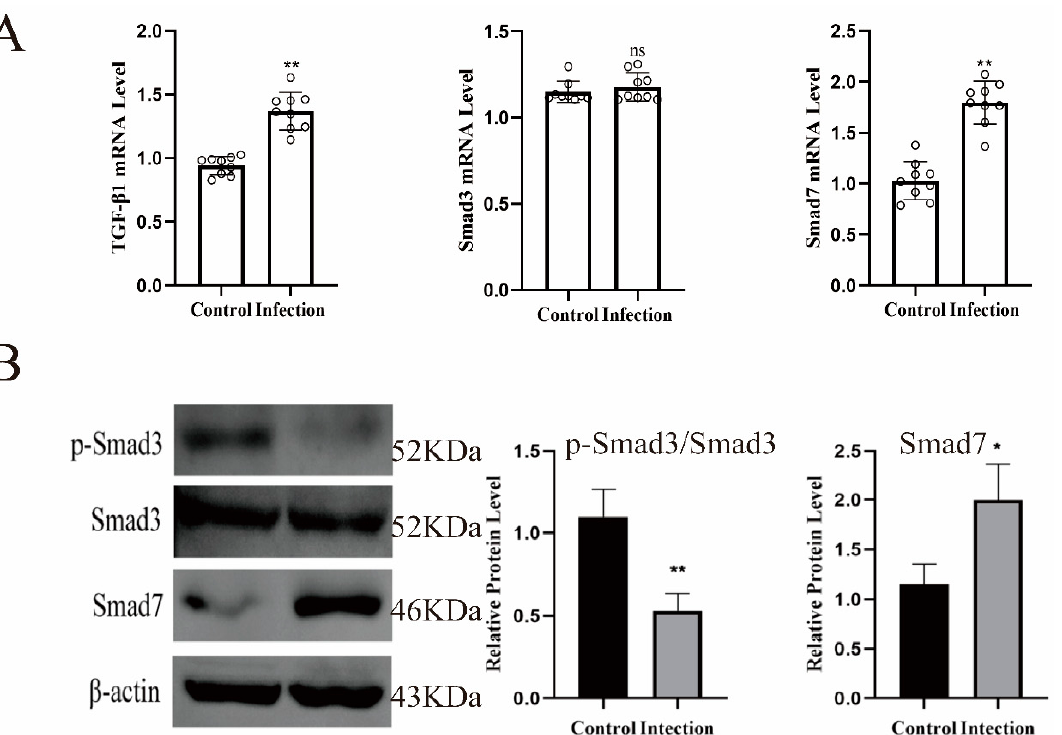
Figure 7. Effects of Escherichia coli on TGF β signaling pathway. ( A ) Effect of Escherichia coli on the mRNA expression of TGF β , smad3, smad7. ( B ) Effects of Escherichia coli on the protein expression of smad3 and smad7. *, p < 0.05, **, p < 0.01, indicating a significant or extremely significant difference compared with the control group.